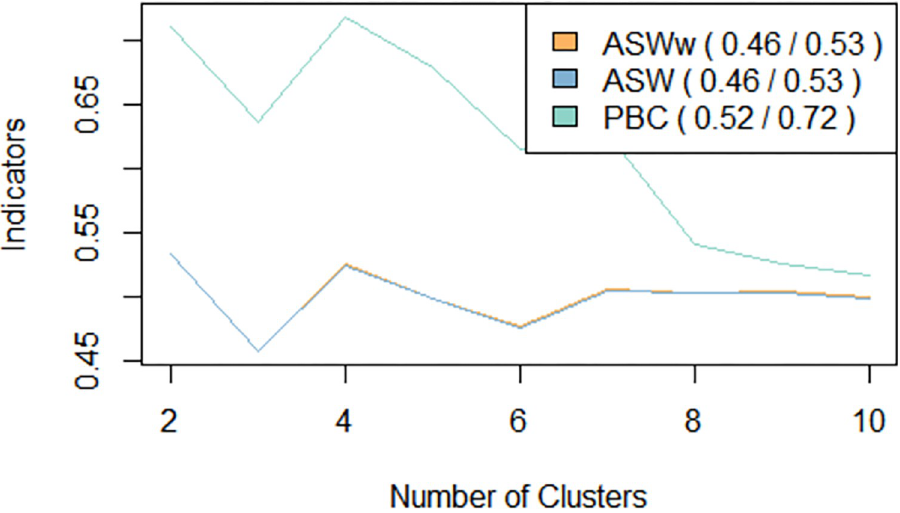
Fig 1. Choosing an optimal number of clusters. (ASW = Average Silhouette Width, ASWw = Average Silhouette Width (weighted), PBC = Point Biserial Correlation).